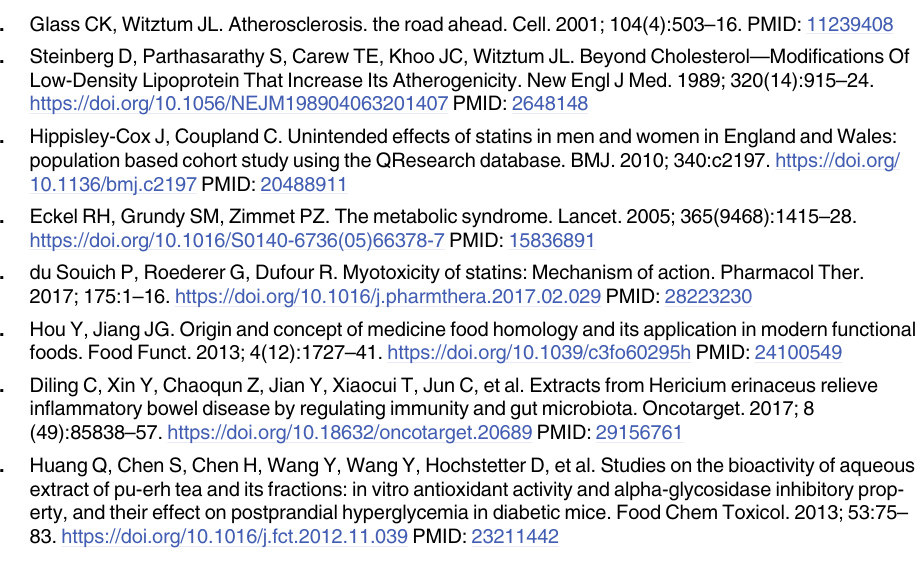
S2 Table. Composition of normal and high-fat diets (HFD). S1 Fig. The HPLC-MS analysis of